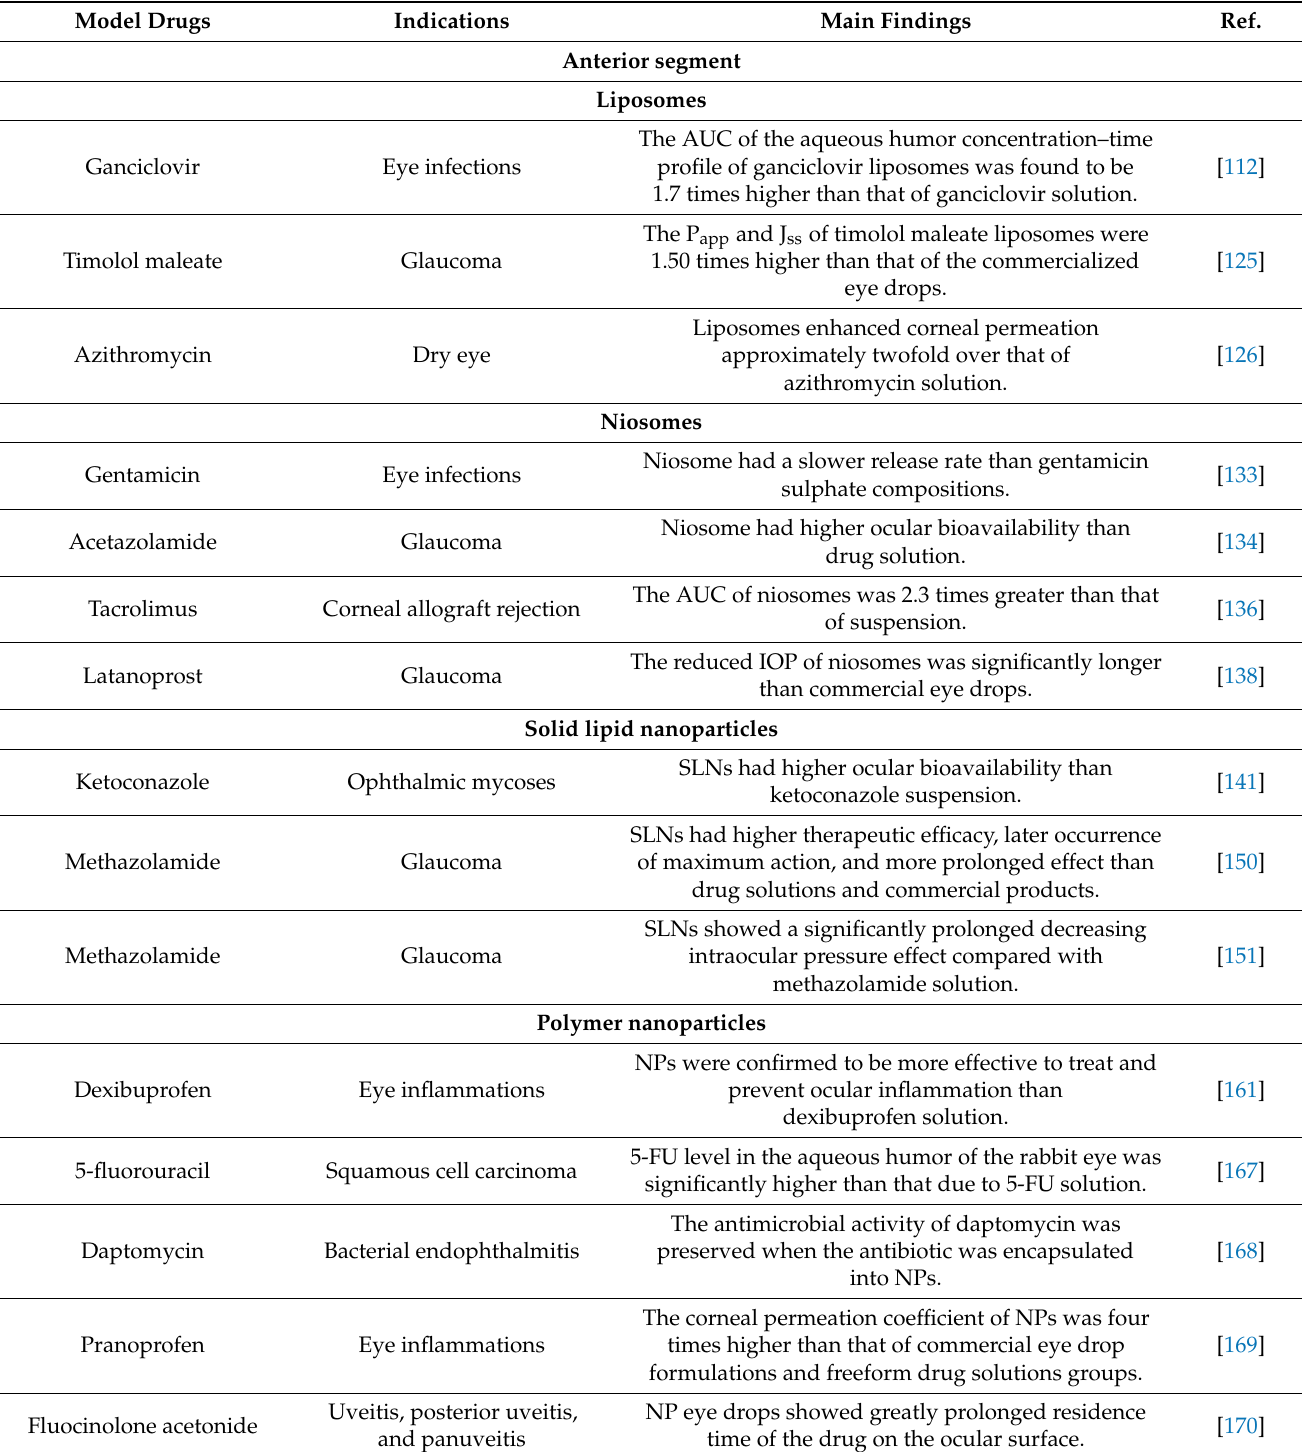
Table 4. Nanoparticle eye drop delivery systems in the application of the anterior and posterior segments of the